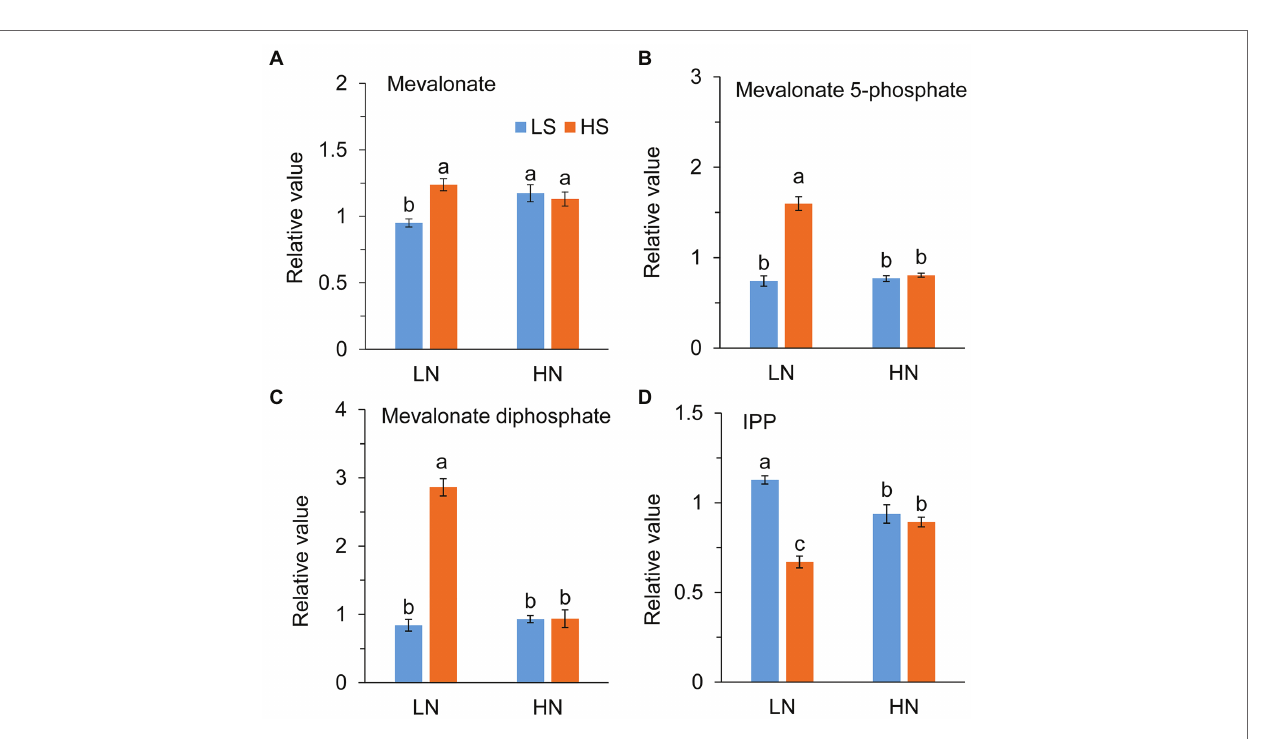
FIGURE 5 | Intermetabolites of terpene metabolism in leaves of A. paniculata plants grown under different nitrogen and sulfur conditions. (A) A Relative value of mevalonate. (B) Relative value of mevalonate 5-phosphate. (C) Relative value of mevalonate diphosphate. (D) Relative value of isopentenyl pyrophosphate (IPP). Data were presented as mean ± SE ( n = 4). Different letters on the bars indicate significant difference among treatments at p < 0.05 using the method of LSD . LN, low nitrogen; HN, high nitrogen; LS, low sulfur; HS, high